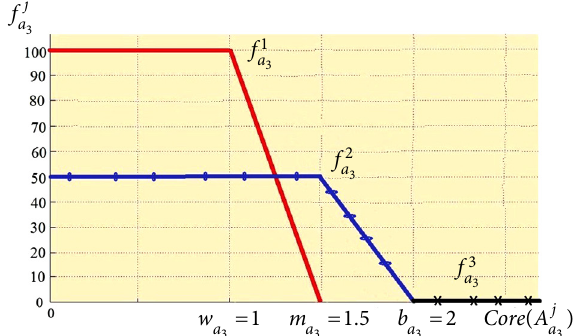
j Figure 3. An example of a function of f that is consistent a 3 with the membership functions shown in Figure 2 and meets the constraints